Question: What type of chart is this?
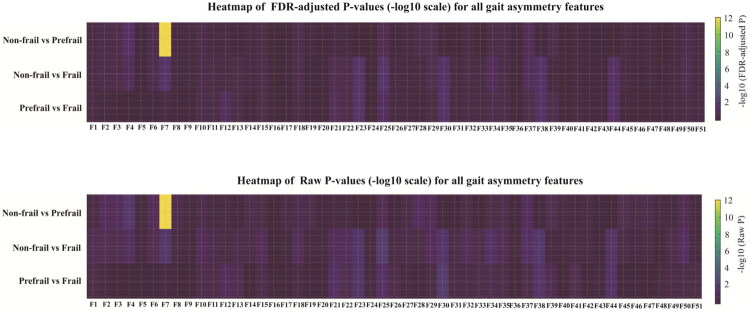
Answer: heatmap